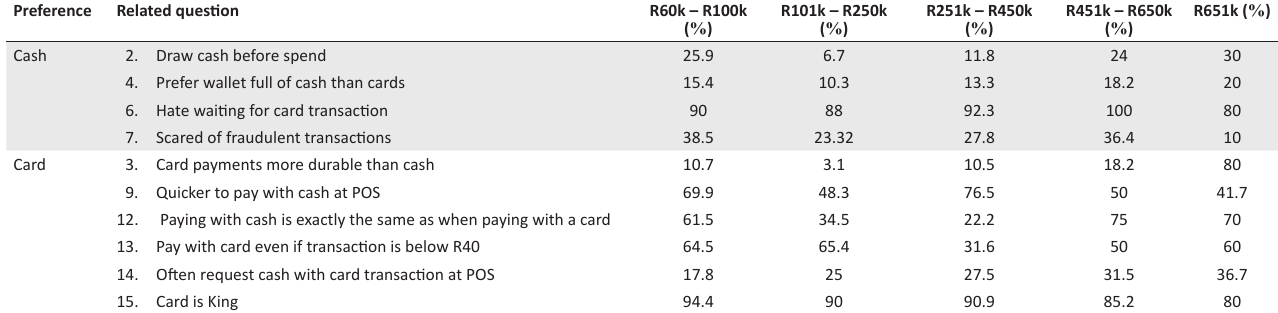
TABLE 2: The preference of either cash or card according to income. Preference Related